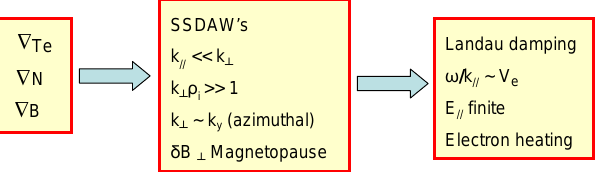
Fig. 10. Sketch summarizing our results. From the left to the right: appropriate gradients generate drift waves with small trans- verse scales. In turn these SSDAWs heat